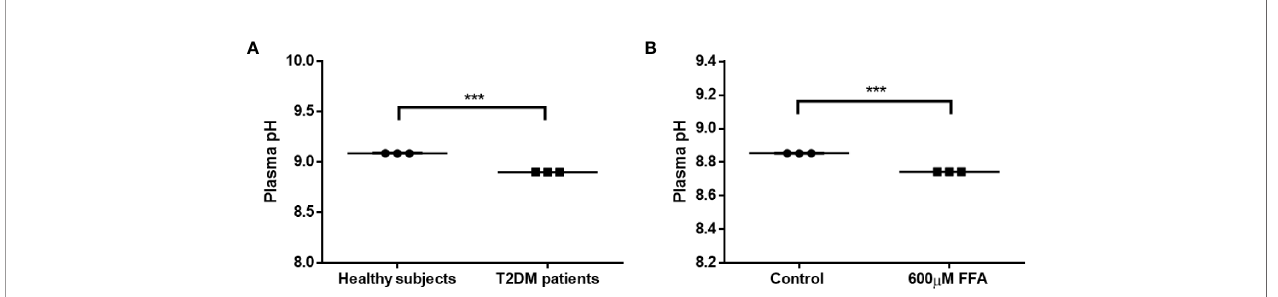
FIGURE 1 | Reduced plasma pH in male type 2 diabetes due to elevated FFA levels. (A) Plasma pH in T2DM male individuals compared to male healthy subjects, (B) the effect of high concentrations of FFA (600 µM) on plasma pH. Data are mean ± SEM. *** p < 0.001. T2DM, type 2 diabetes